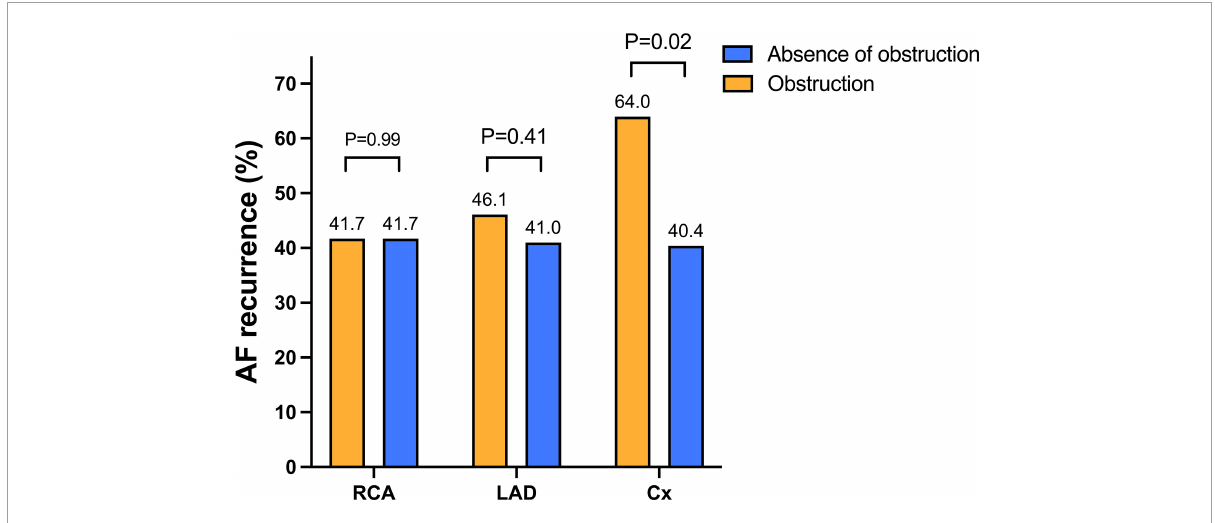
FIGURE1 Atrial fibrillation recurrence according to the localization of the obstruction. Arrhythmia recurrences did not differ between obstructed and non-obstructed groups regarding the LAD and the RCA. On the contrary, AF recurrences were higher in patients with circumflex artery obstruction compared to patients without circumflex artery obstruction. Abbreviations: AF, atrial fibrillation; Cx, circumflex artery; LAD, left anterior descending; RCA, right coronary